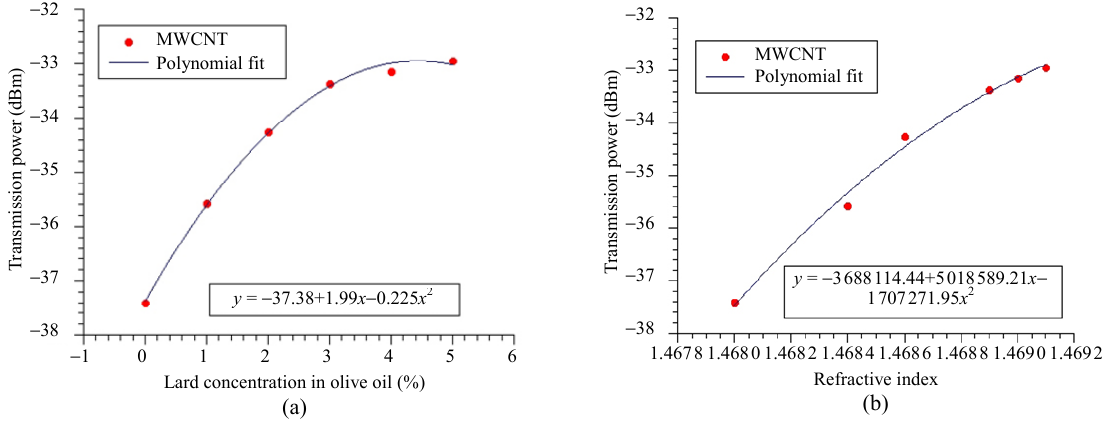
Fig. 7 Transmission power of the MWCNTs-coated tapered POF as a function of (a) lard concentration in olive oil and (b) refractive